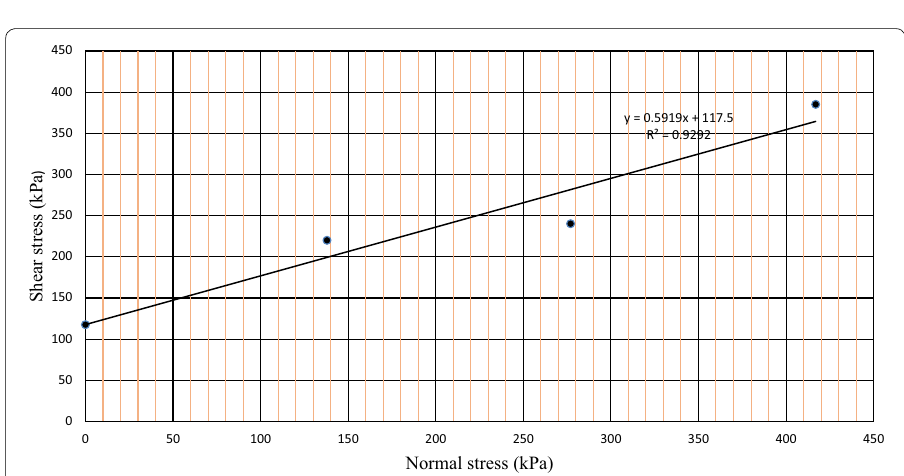
y = 0.5919x + 117.5 R² = 0.9292